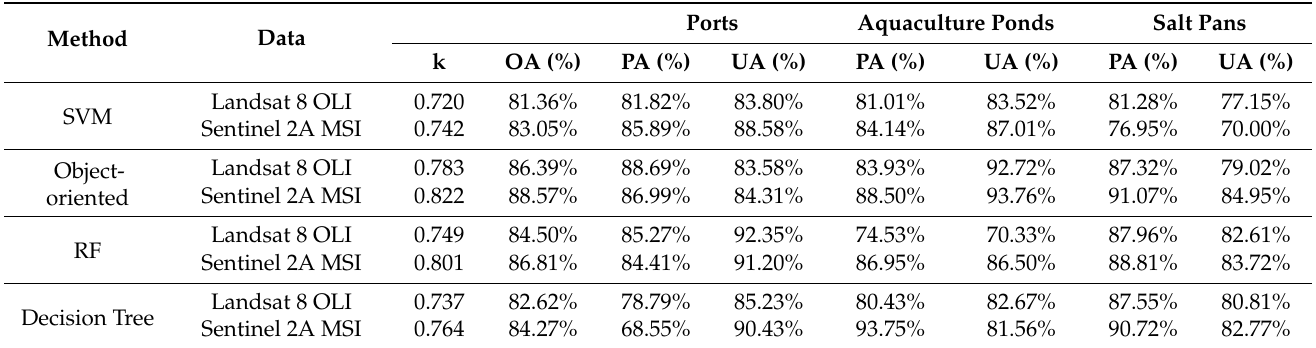
Table 7. Accuracy validation in west Guangdong.